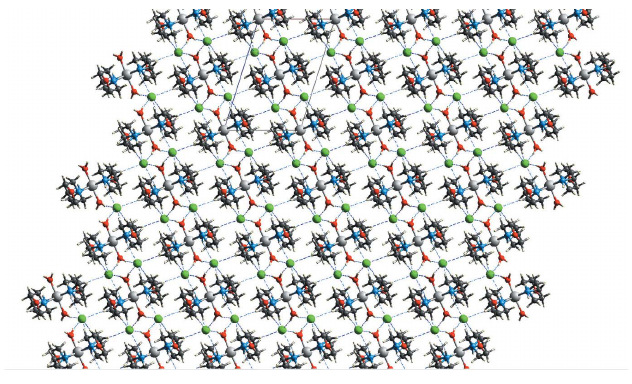
Figure 4 Crystal structure of the title compound viewed down the b -axis direction. Dotted lines represent supramolecular interactions.